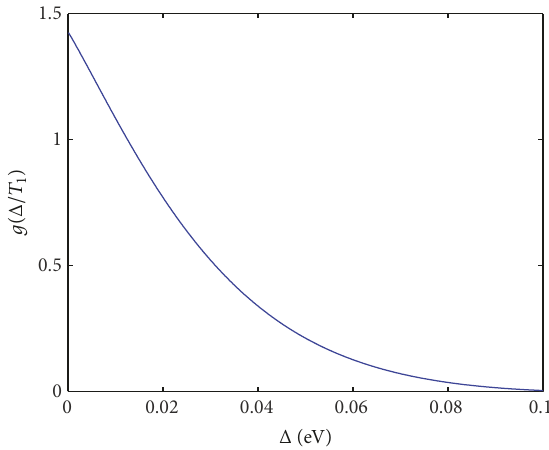
Figure 3: The function 𝑔(Δ/𝑇 1 ) for sterile neutrino scattering by an atom as a function of the excitation energy in